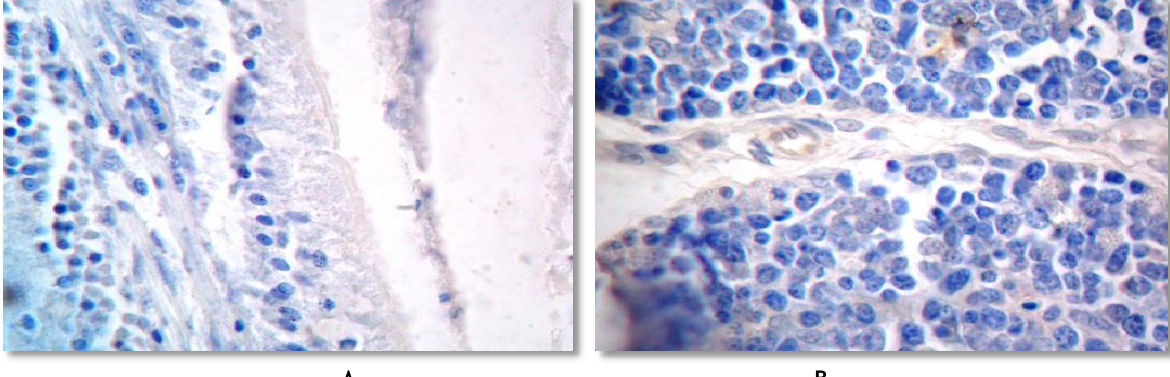
A B Figure,8: A:Immunohistochemical staining of the duodenum in non-heat stressed non treated 24 days old chick G4, the paraffin embedded section (5µm) appears no stained cells..B: Immunohistochemical staining of the bursa of fabricius in non-heat stressed non treated 24 days old chick G4, the paraffin embedded section (5µm) appears no stained cells. 100